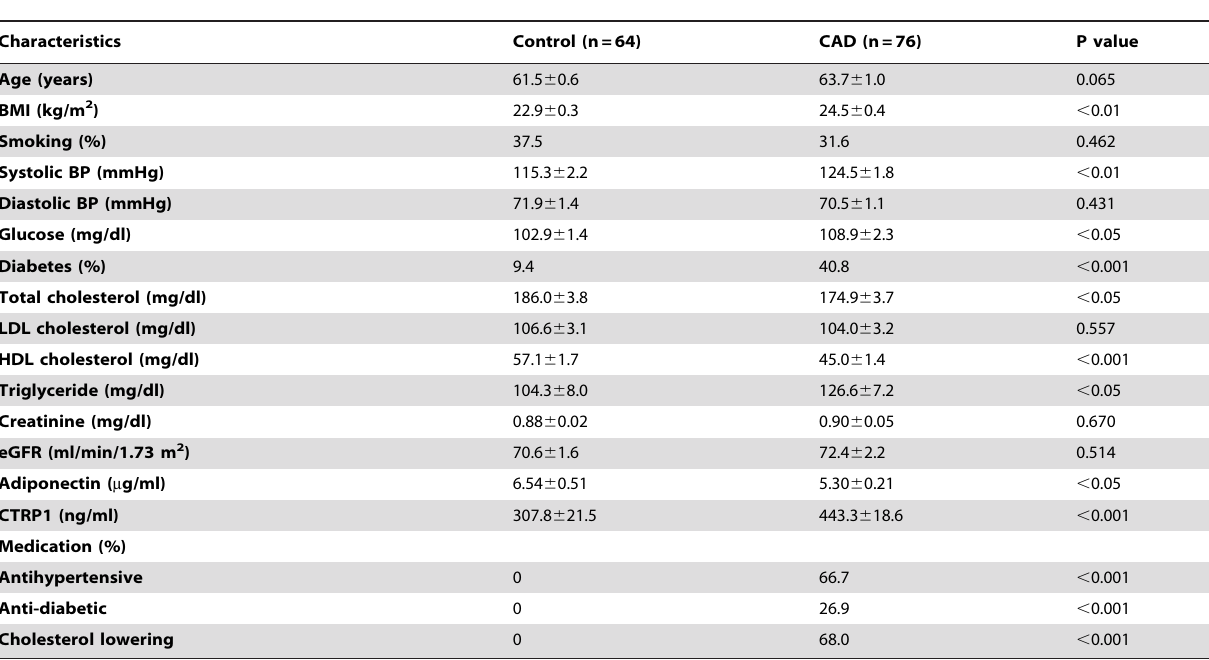
Table 1. Clinical characteristics of control subjects and CAD patients.